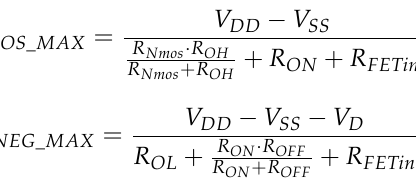
direction. In the turn-off time, the diode is in the conducting stage and the resistors are